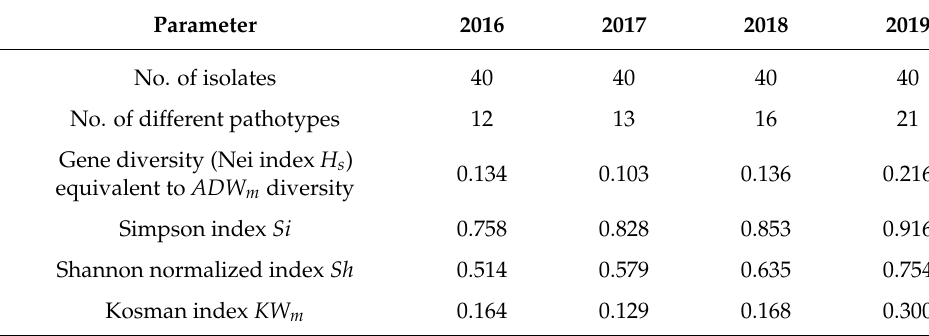
Table 5. Diversity analysis of all powdery mildew